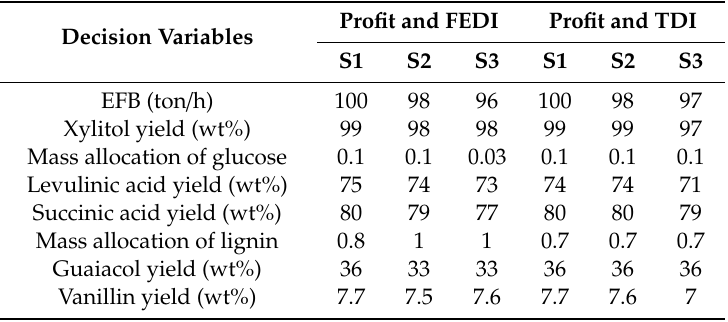
Figure 8. Pareto-optimal fronts for ( a ) profit versus fire explosion damage index and ( b ) profit versus toxicity damage index. Table 9. Decision variables that correspond to the selected optimal solutions in Figure 8.